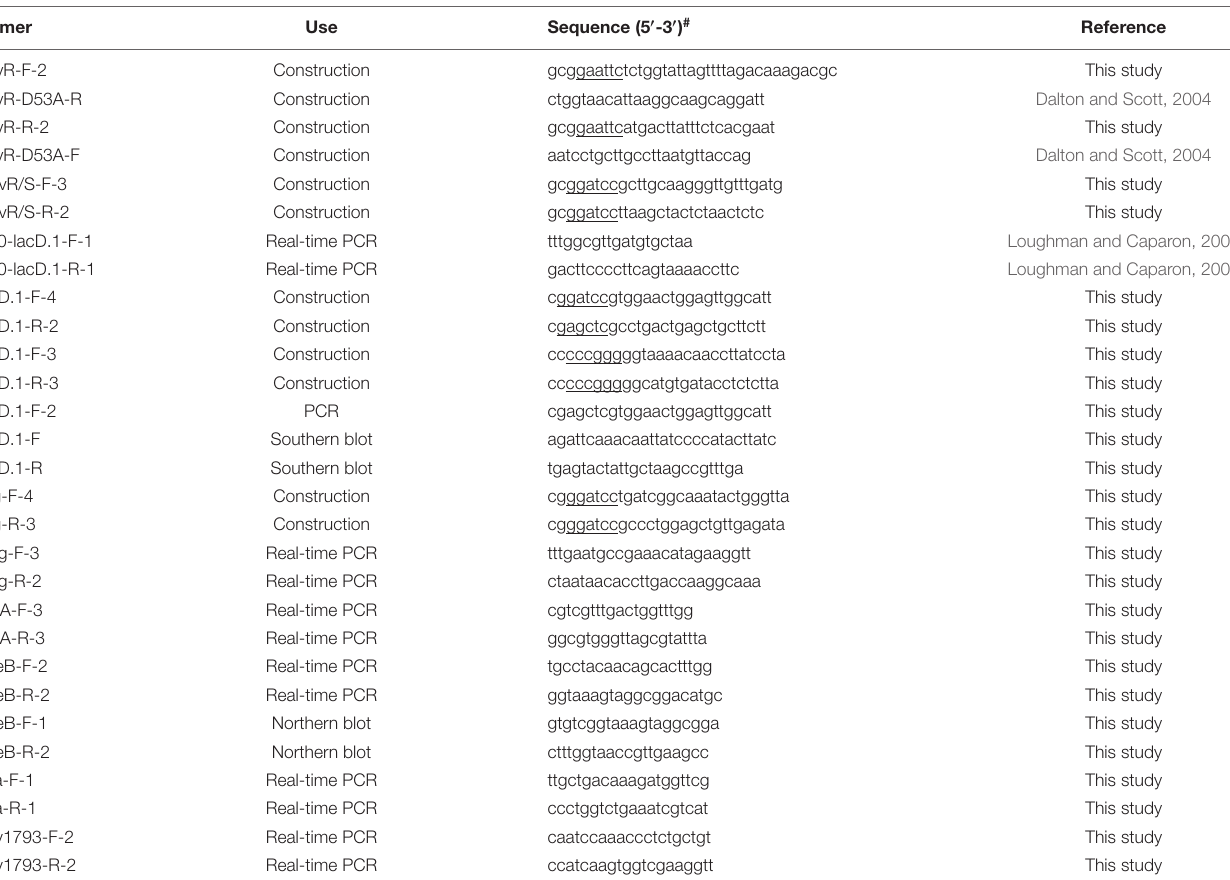
TABLE 2 | Primers used in this